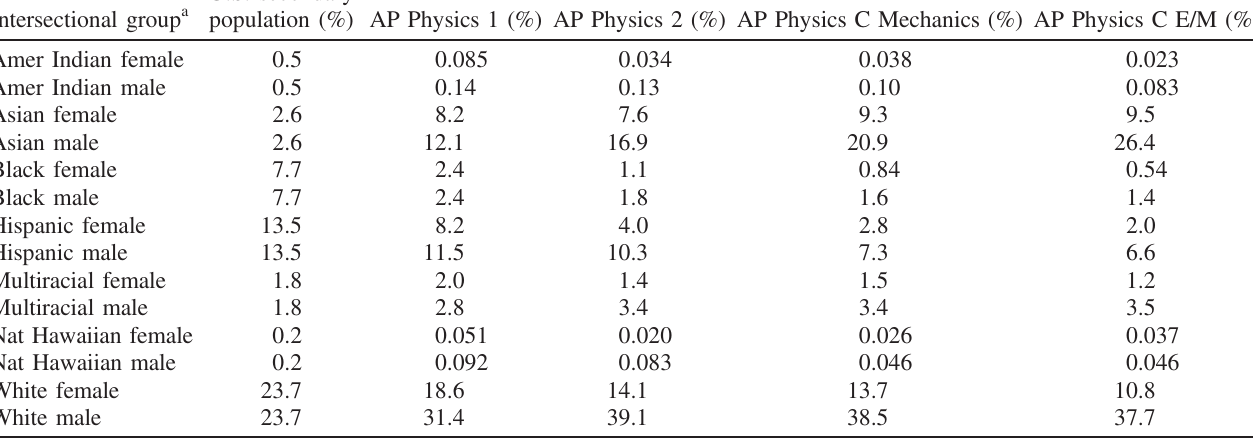
TABLE I. AP Physics enrollment percentages by intersectional group as compared to U.S. secondary enrollment in grades 9 – 12, 2018